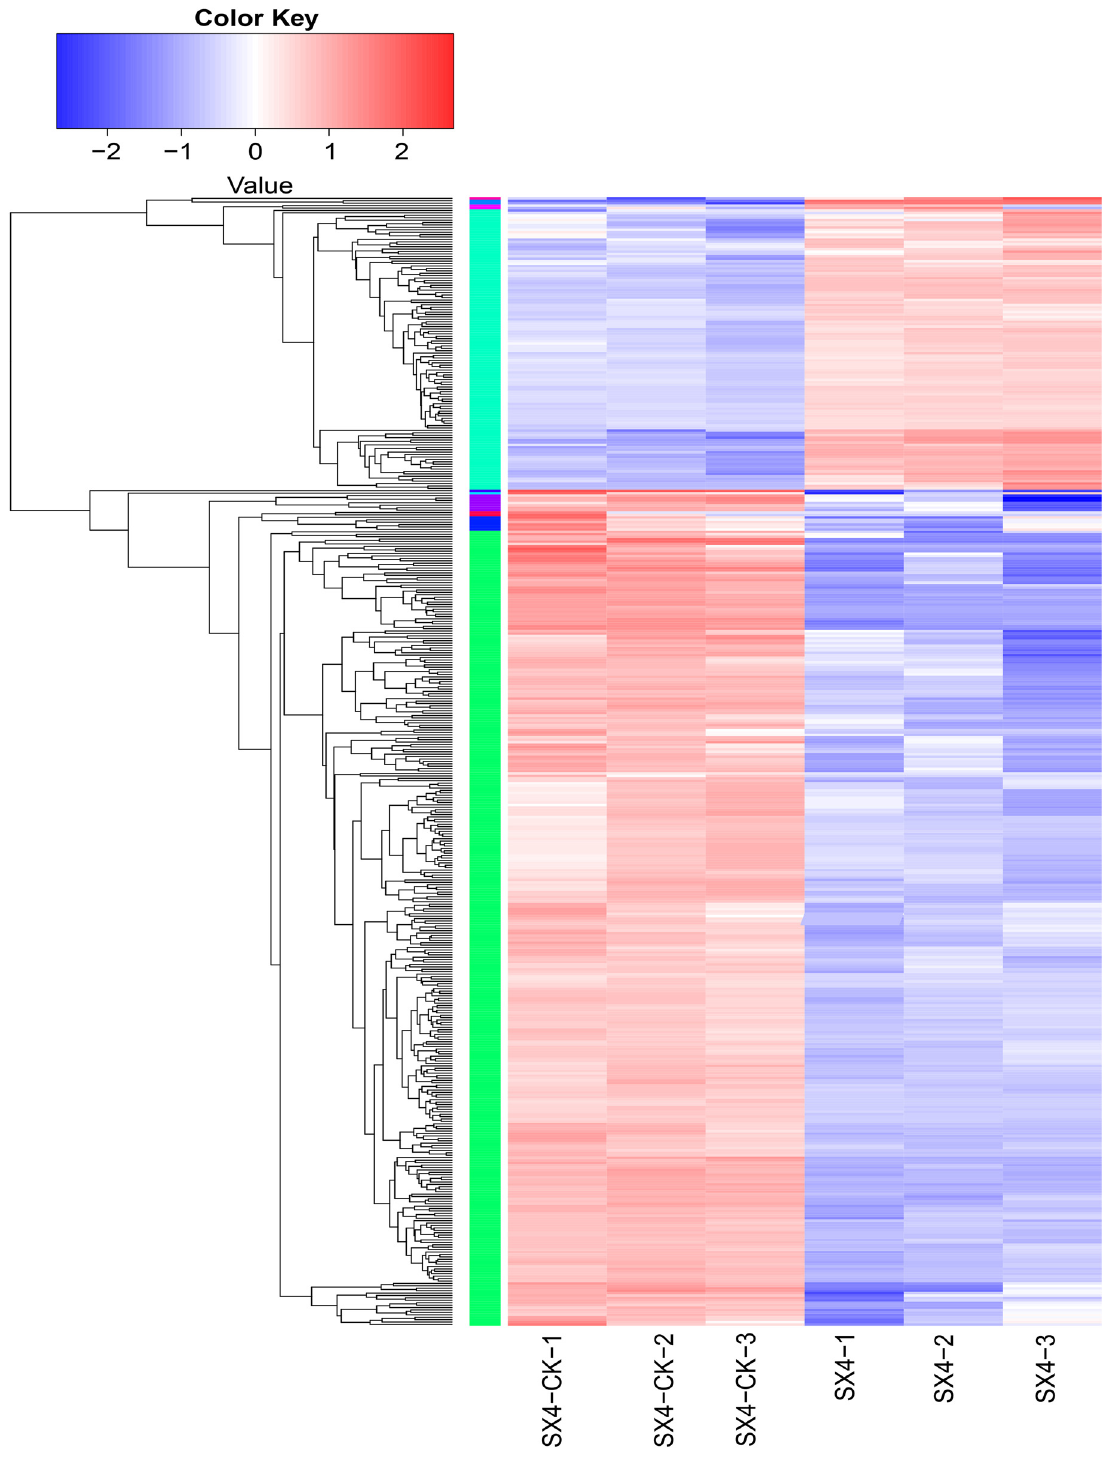
Figure 7: Clustering heatmap analysis of di ff erentially expressed